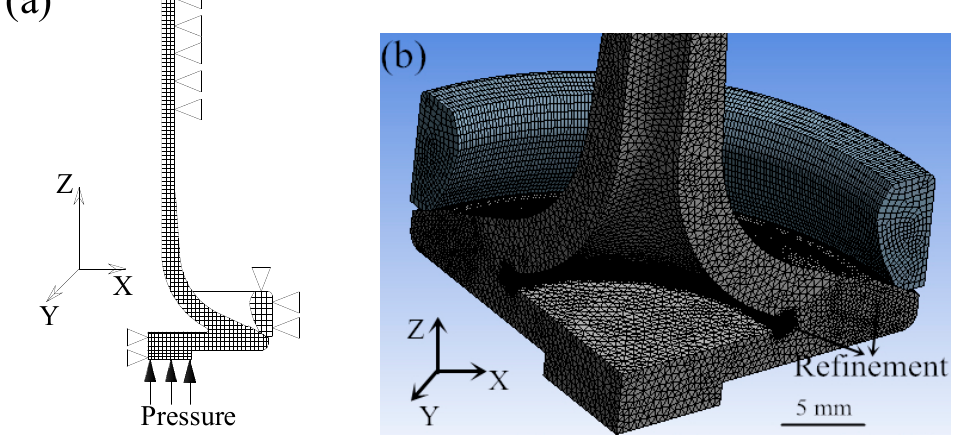
Figure 15. ( a ) Axisymmetric finite element method model of HHSV; ( b ) element mesh of finite element method model of HHSV.